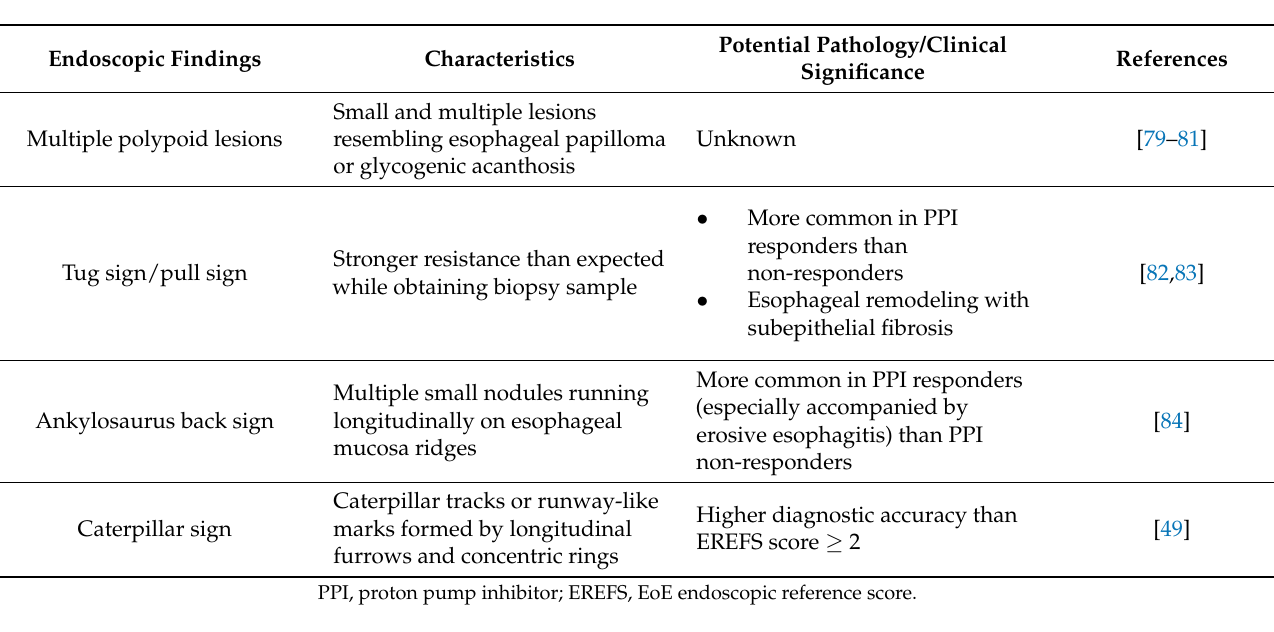
Table 3. Characteristics, potential pathology and clinical significance of other endoscopic findings related to EoE.